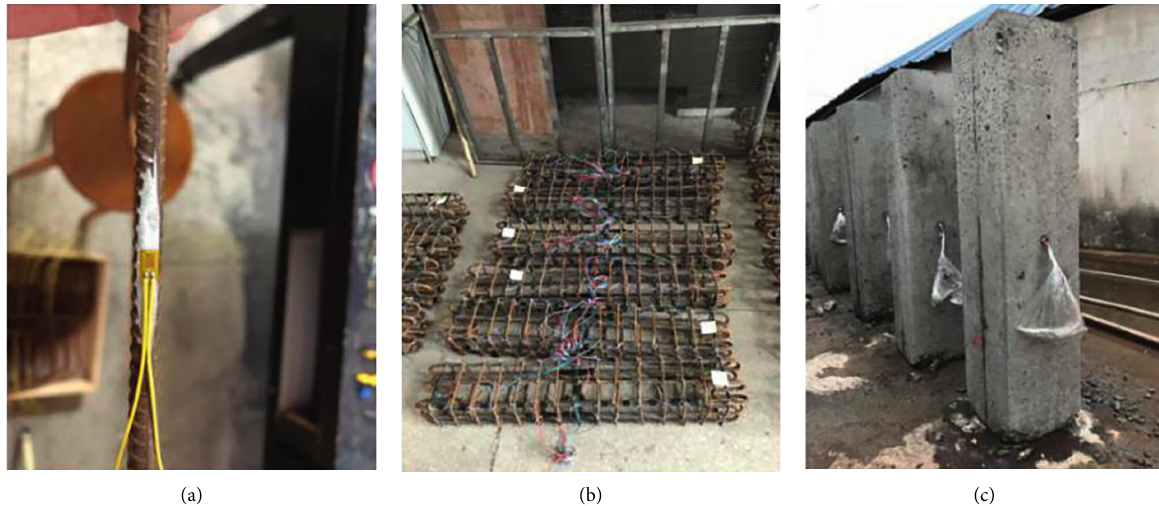
Figure 4: Process of specimen fabrication. (a) Bonding strain gauges. (b) Reinforcement cage processing. (c) Room temperature maintenance of